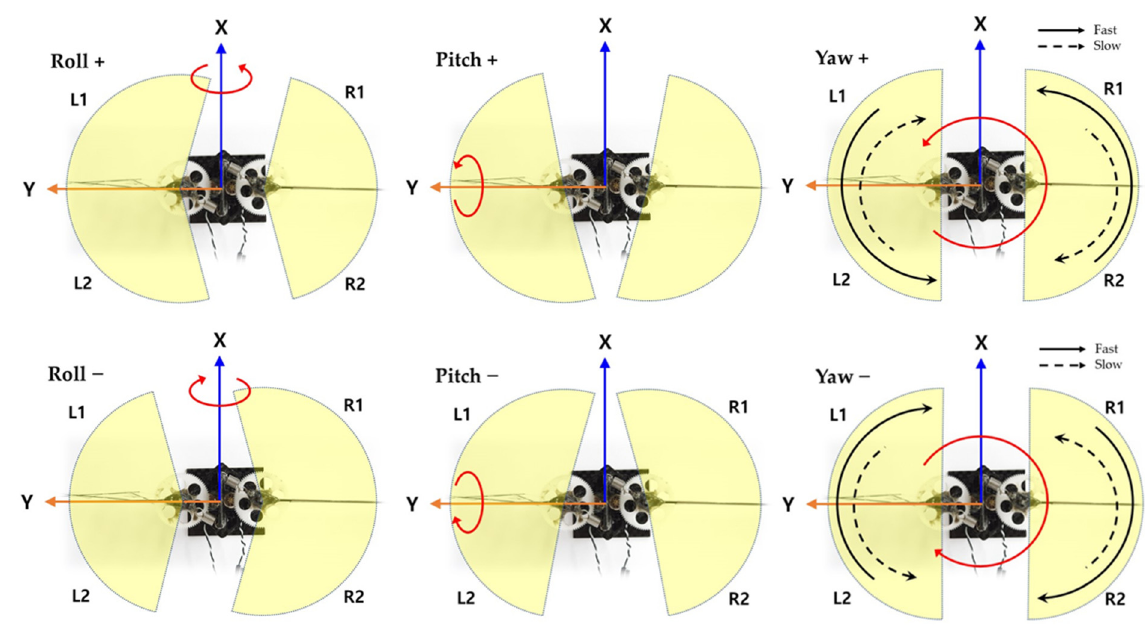
Figure 7. Wing flapping variations for roll, pitch, and yaw maneuvering.